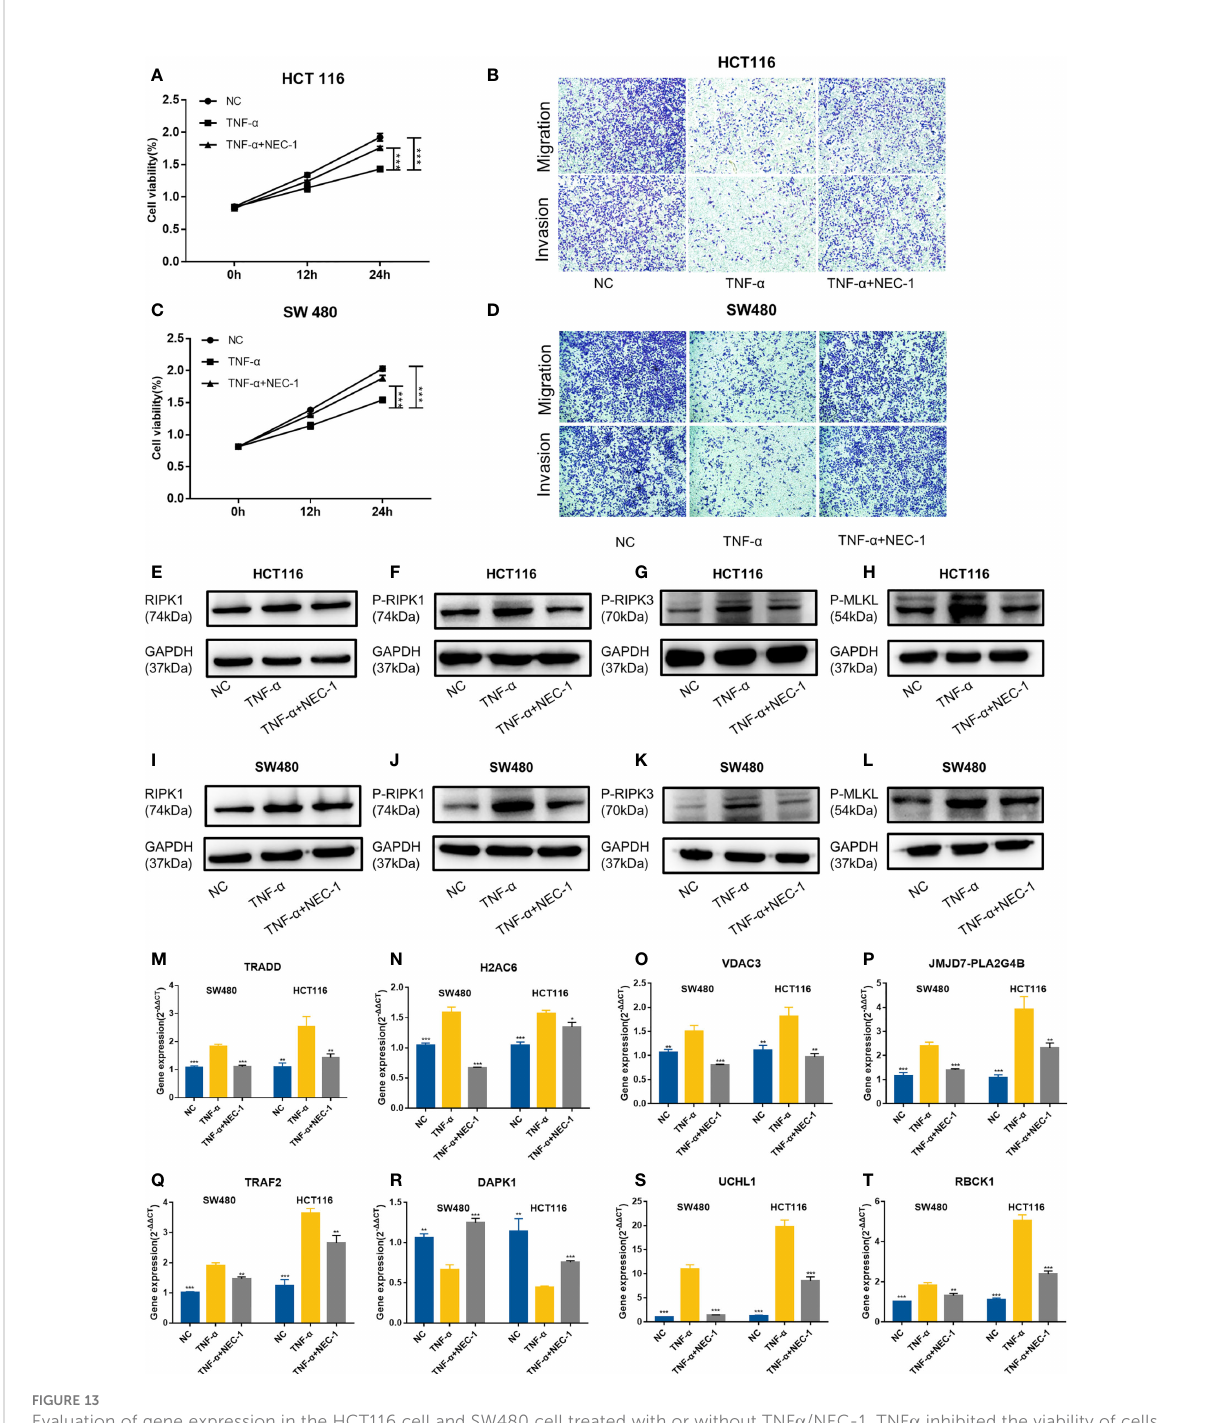
FIGURE 13 Evaluation of gene expression in the HCT116 cell and SW480 cell treated with or without TNF a /NEC-1. TNF a inhibited the viability of cells and NEC-1 can counteract the effects of TNF a on HCT116 cells (A) and SW480 cells (C) . TNF a inhibited the migration and invasion ability of cells and NEC-1 can counteract the effects of TNF a on HCT116 cells (B) and SW480 cells (D) . Representative images of the Western blot analysis of RIPK1 (E) , P-RIPK1 (F) , P-RIPK3 (G) , and P-MLKL (H) in the HCT116 cells and RIPK1 (I) , P-RIPK1 (J) , P-RIPK3 (K) , and P-MLKL (L) in the SW480 cells treated with or without TNF a /NEC-1. Eight necroptosis-related genes [ TRADD (M) , H2AC6 (N) , VDAC3 (O) , JMJD7- PLA2G4B (P) , TRAF2 (Q) , DAPK1 (R) , UCHL1 (S) , RBCK1 (T) ] in the cells treated with or without TNF a /NEC-1. * P < 0.05, ** P < 0.01, *** P < 0.001 versus the TNF a